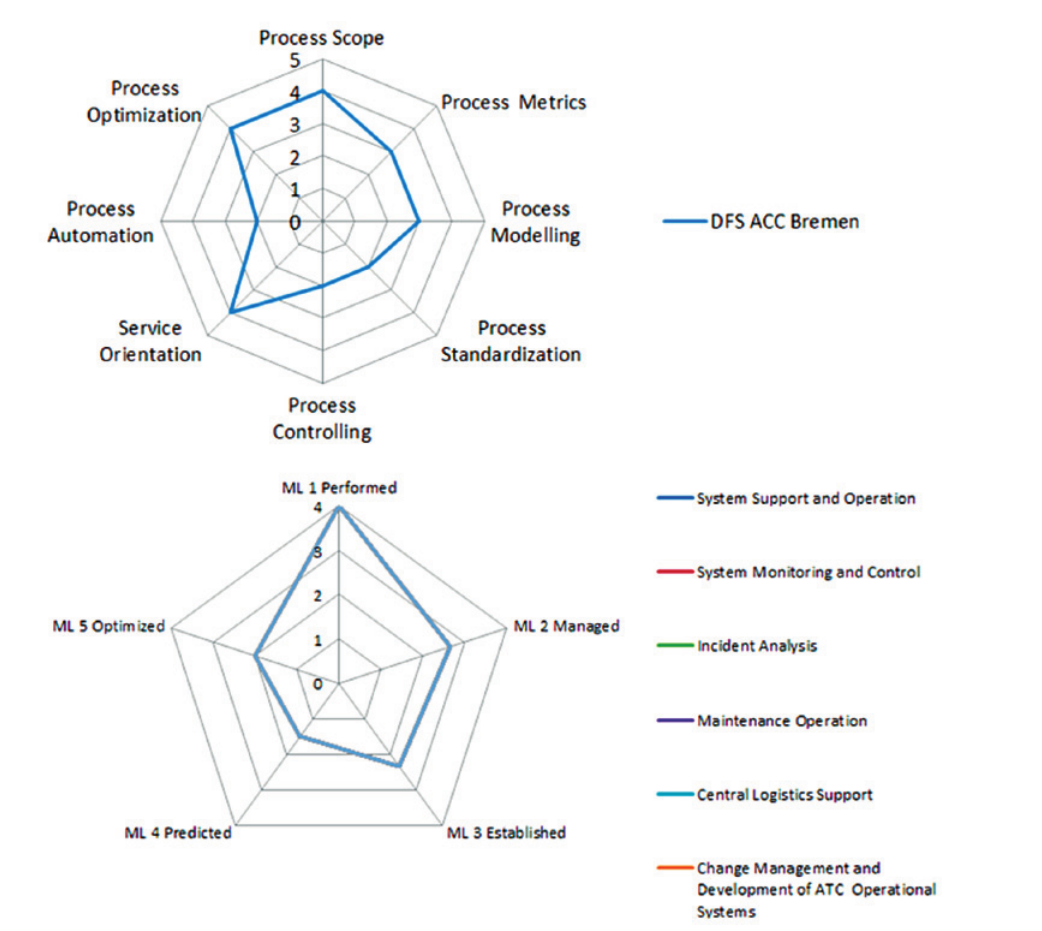
Fig. 4. DFS ATC maintenance process maturity assessments. The process types marked by various colours mentioned on the right side of the ML diagram completely